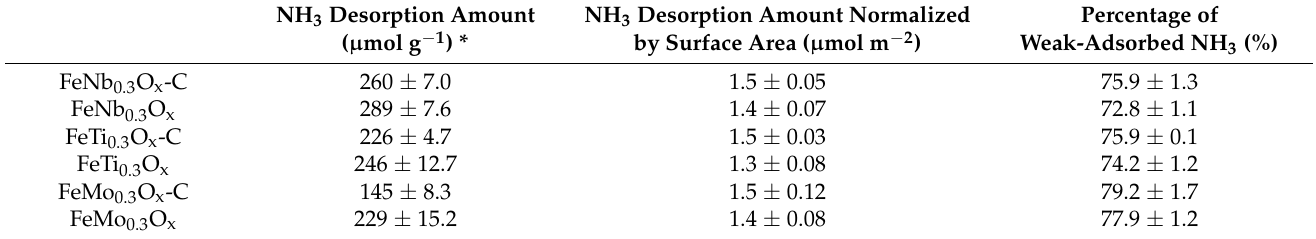
Figure 3. XRD patterns of ( a ) FeM 0.3 O x -C and ( b ) FeM 0.3 O x (M = Nb, Ti, Mo) samples. Table 3. Desorption amount of NH 3 and percentage of weak-adsorbed NH 3 over all the FeM 0.3 O x -C and FeM 0.3 O x (M = Nb, Ti, Mo) samples.